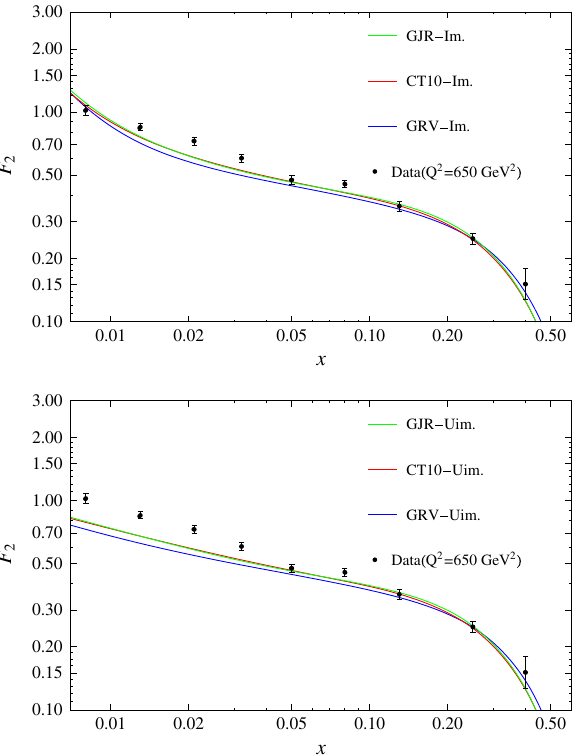
Fig. 3 Nucleon structure function (NSF), F 2 ( x ) , at Q 2 = 650 GeV 2 , compared with the available experimental data [64], using the GRV, CT10andGJRmodels.Here“Im.”indicatesourresultsforthemodified NSF ( up panel ), and “Uim.” denotes the normal NSF ( down panel ), using the three mentioned